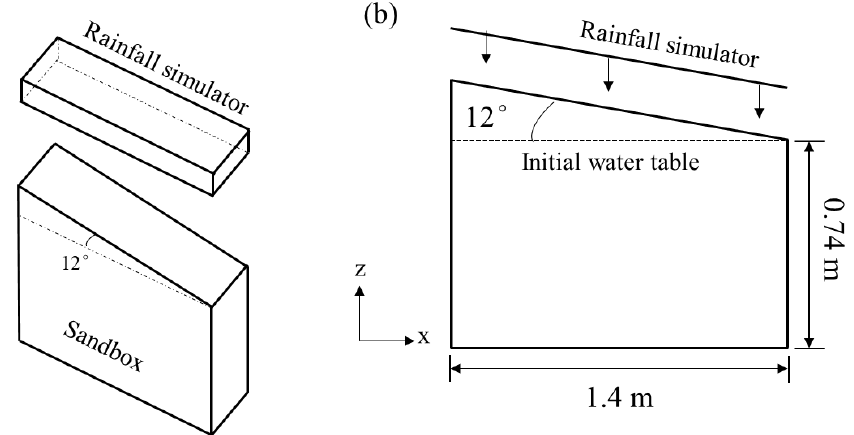
Figure 4. Computational domains of the 2D sandbox: ( a ) Schematic description of the sandbox; ( b ) 2D view of the sandbox. 2D view of the